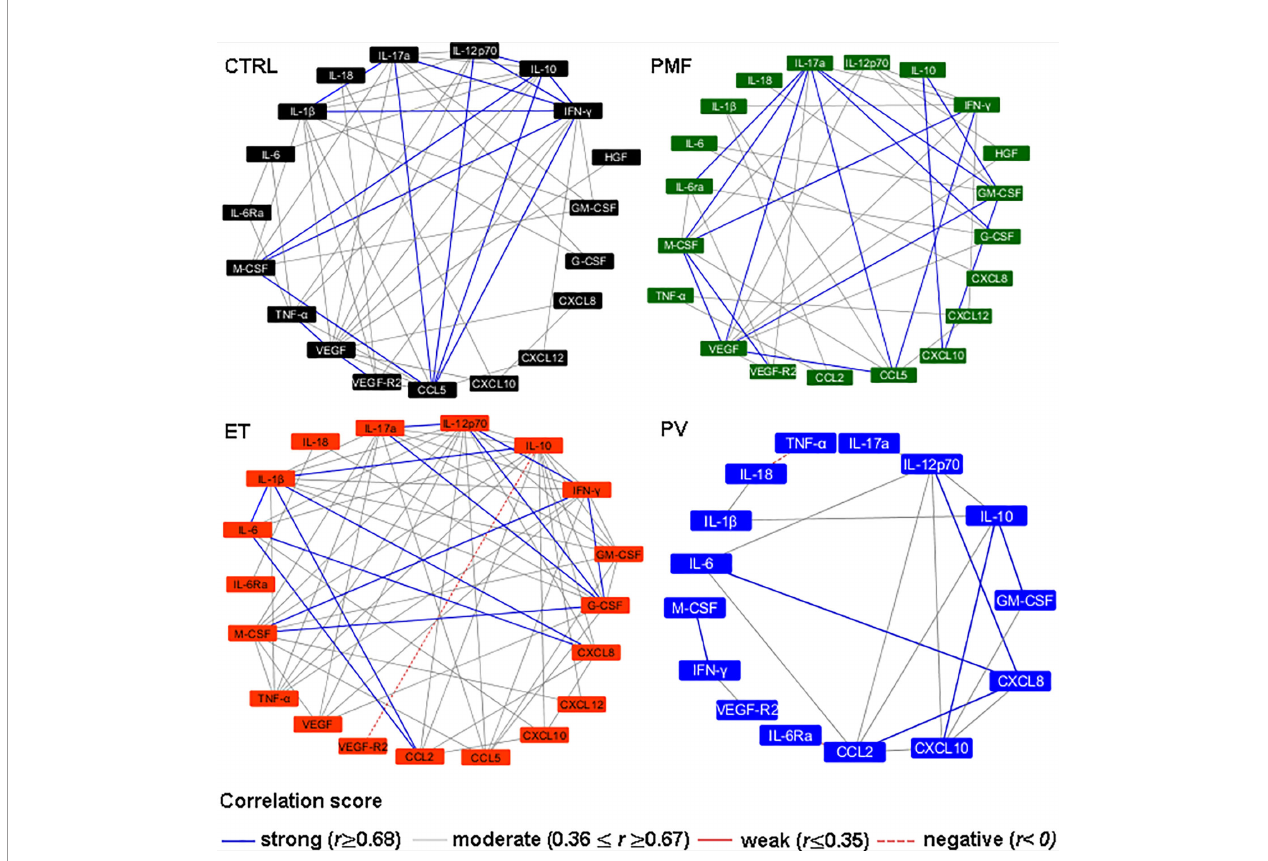
FIGURE 2 | Soluble mediators interaction networks in healthy subjects (CTRL, n = 17) and patients with essential thrombocythemia (ET, n = 28), polycythemia vera (PV, n = 19), and primary myelo fi brosis (PMF, n = 16). The correlations were strati fi ed according to r -values: strong (blue lines, r ≥ 0.68), moderate (gray lines, 0.36 ≤ r ≥ 0.67) and negative (dashed red line, r <0). The correlations depicted in this fi gure were signi fi cant (p